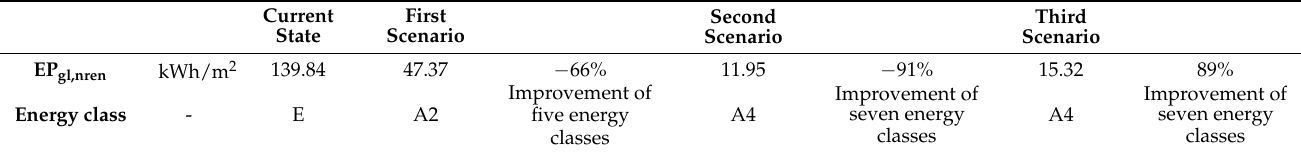
Table 8. Energy performance index and energy classes for all the cases.